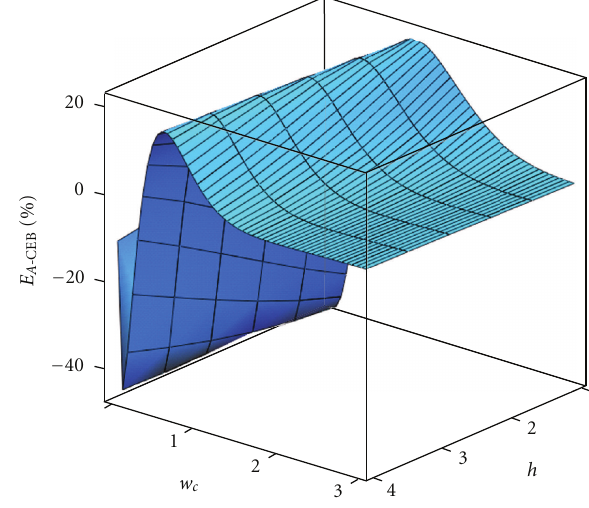
Figure 10: E N -CEB ( h , w c ) for β s = 500.